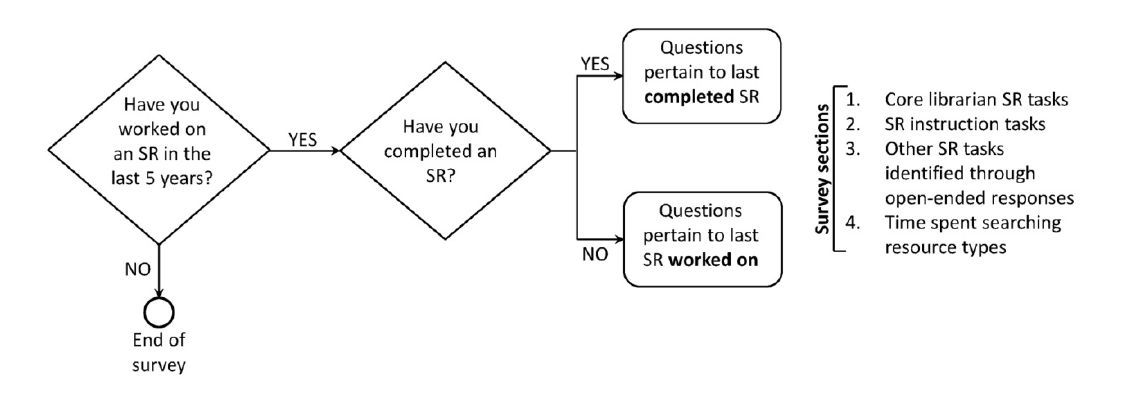
Figure 1 Flowchart of the survey